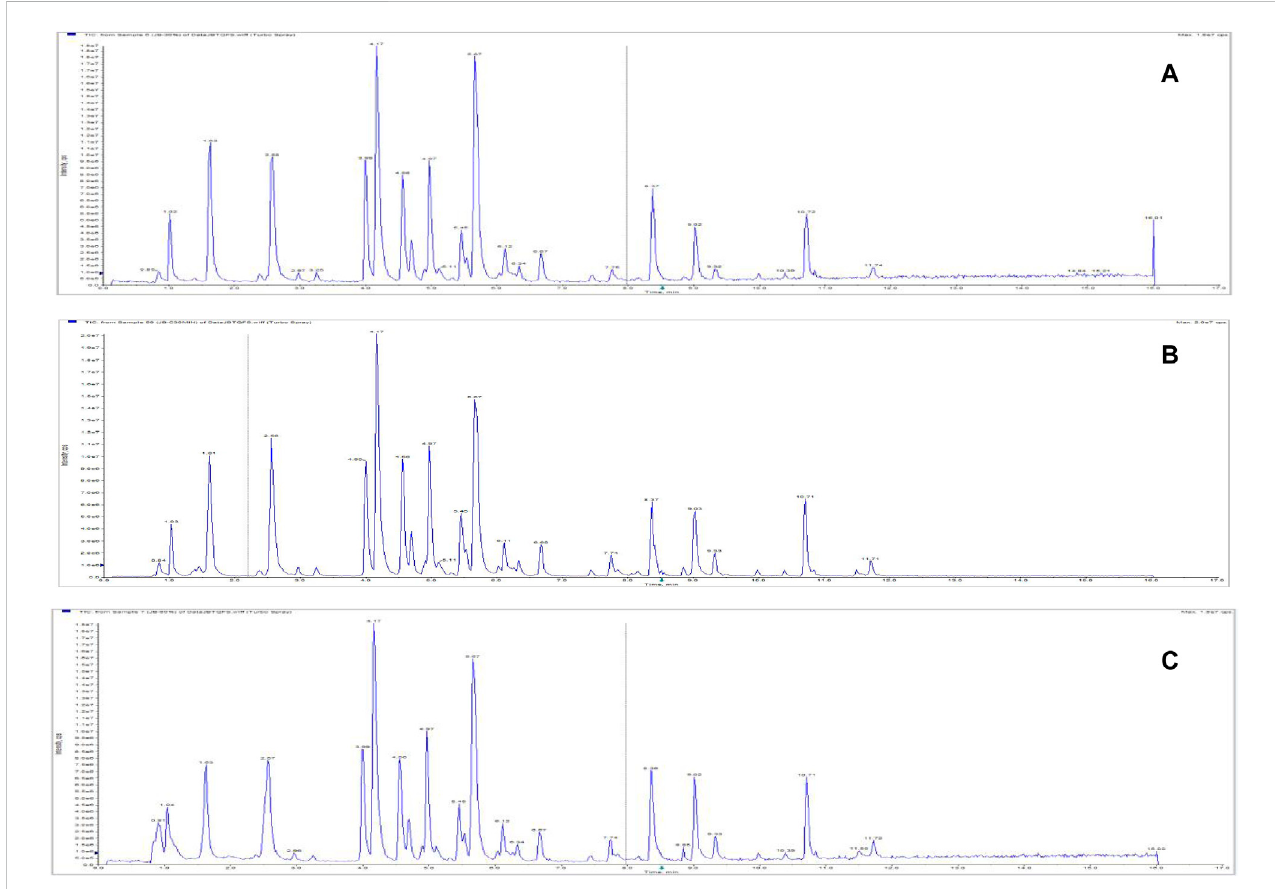
FIGURE 11 Total ion chromatograms of Jinbei oral liquid by different extraction solvents. (A) 30% methanol; (B) 50% methanol; (C) 80% methanol See Supplementary Data Sheet 3.